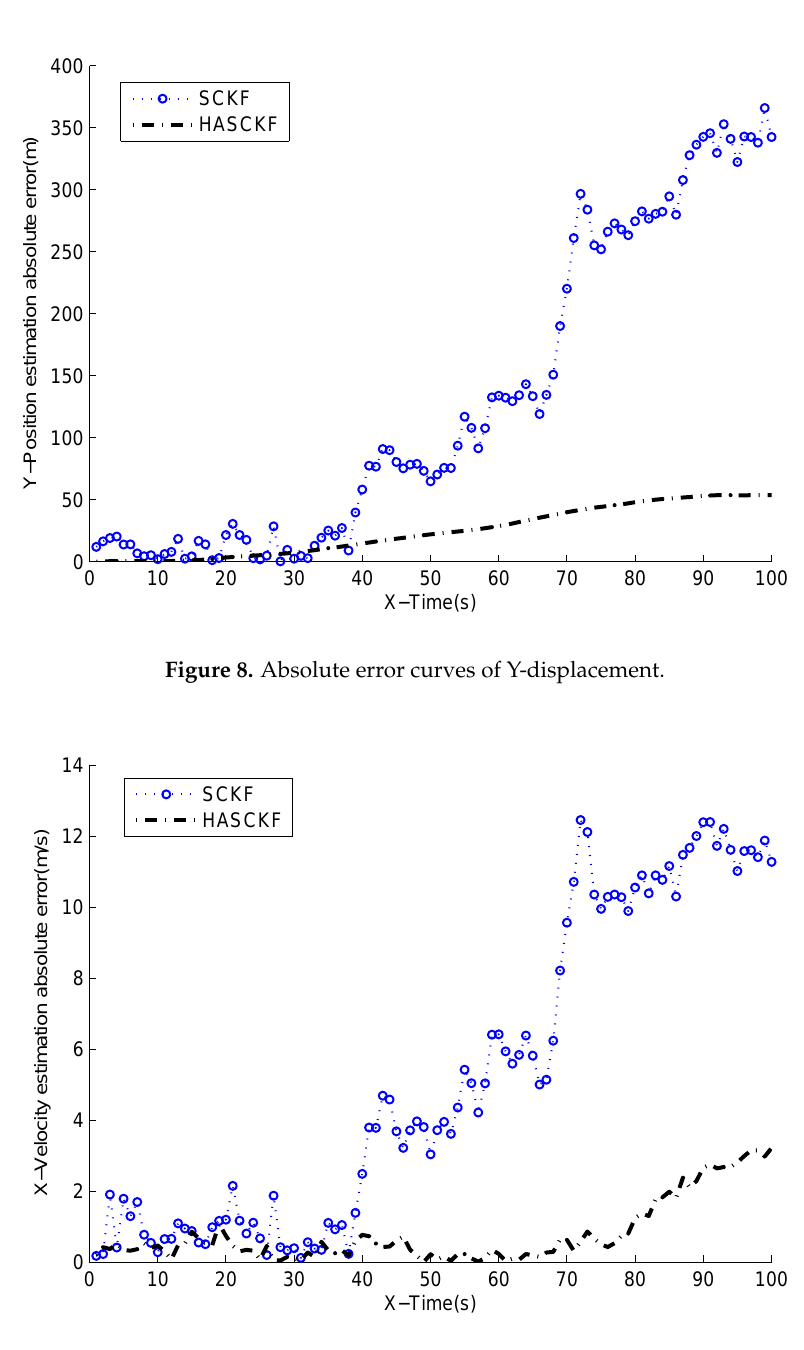
Figure 9. Absolute error curves of